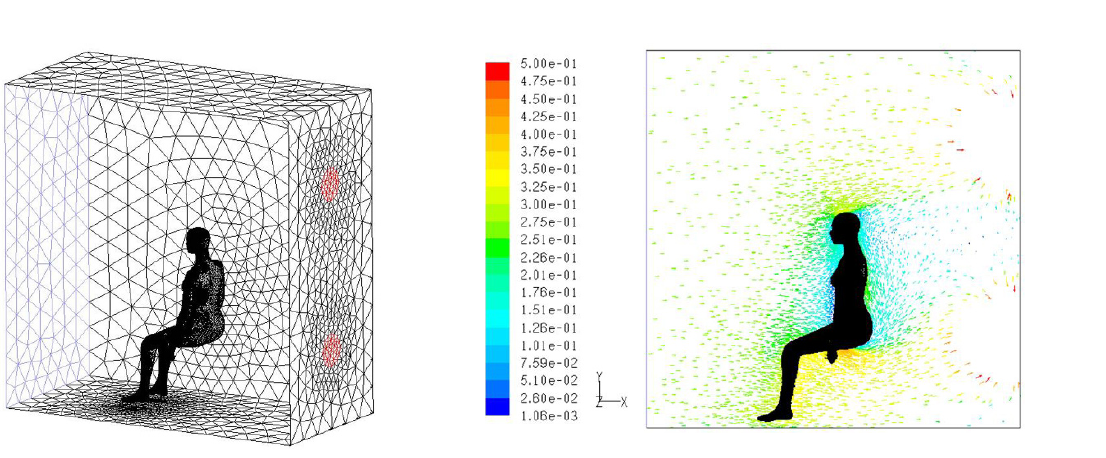
Figure 4. Computational mesh composed of tetrahedral elements.